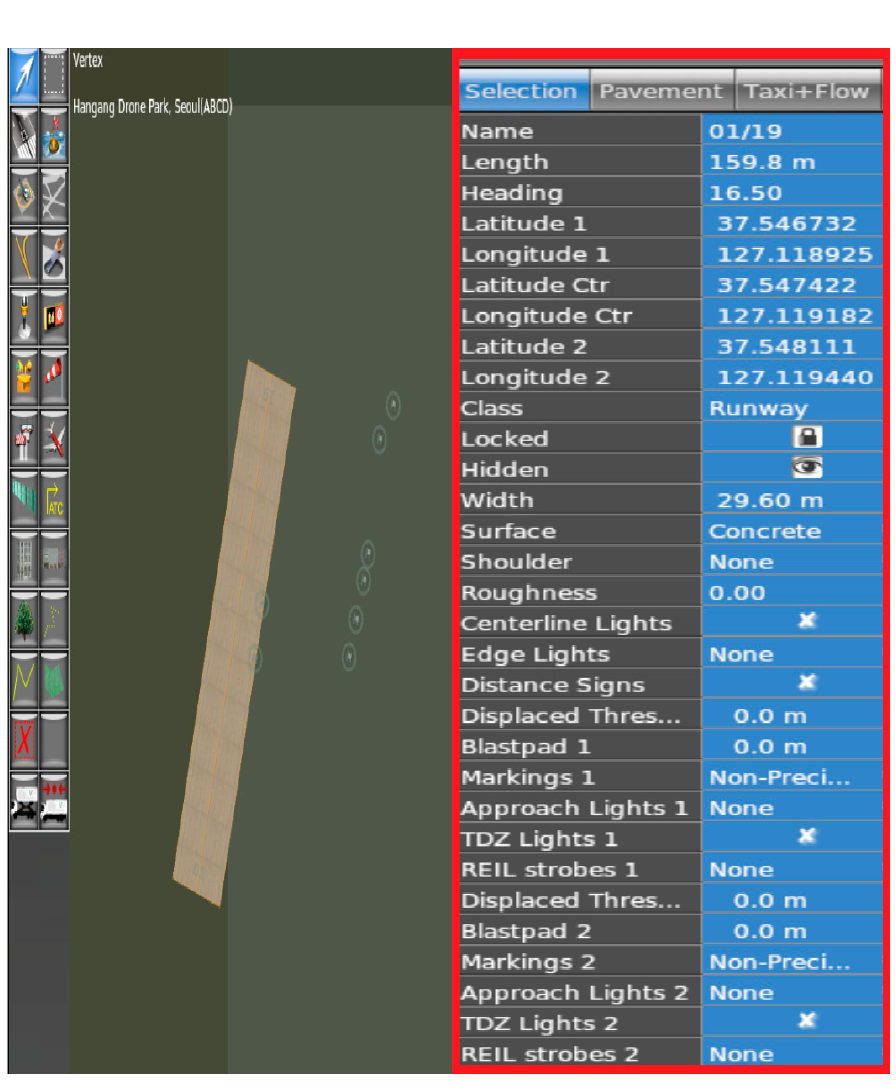
Figure 5. Design parameters of virtual location (on WorldEditor).